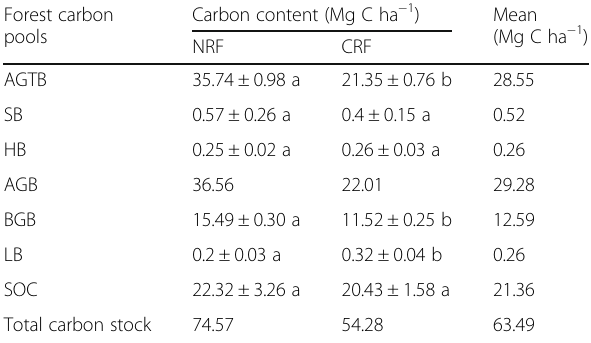
Allocation pattern of C in different pools